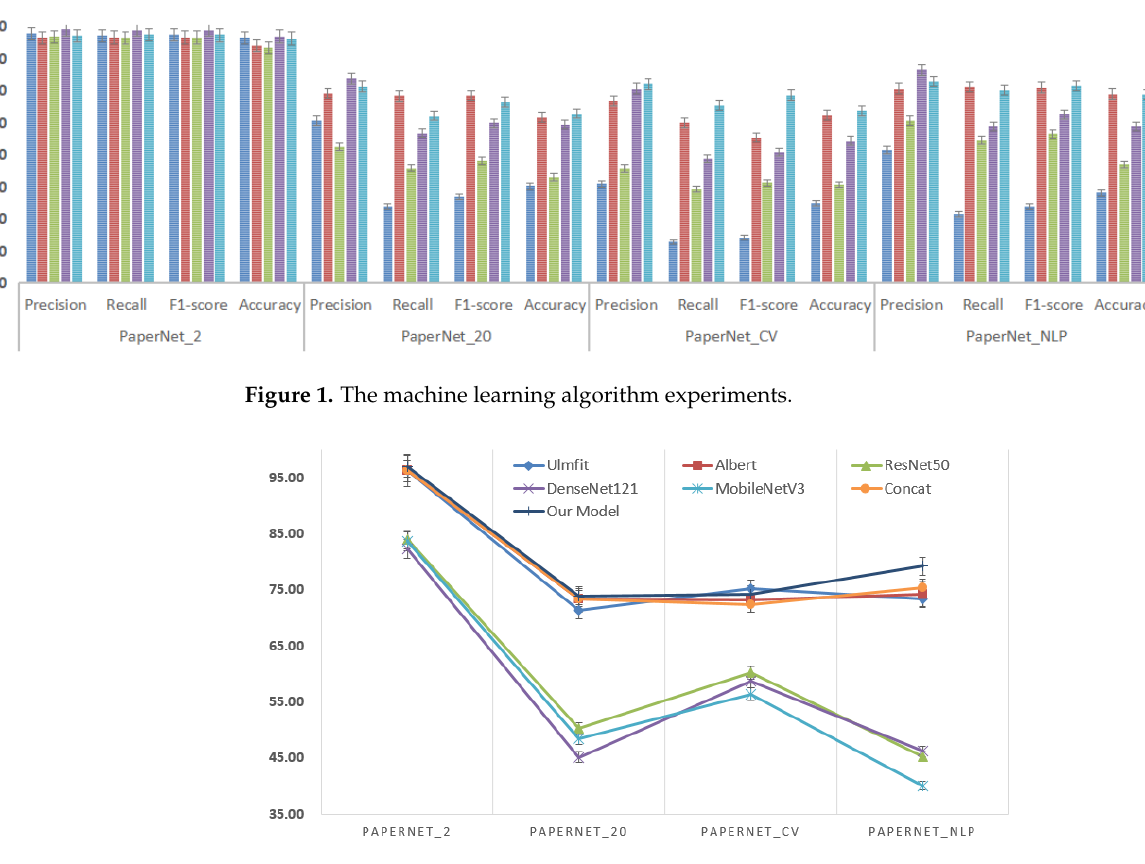
Figure 2. Popular pre-trained model accuracy